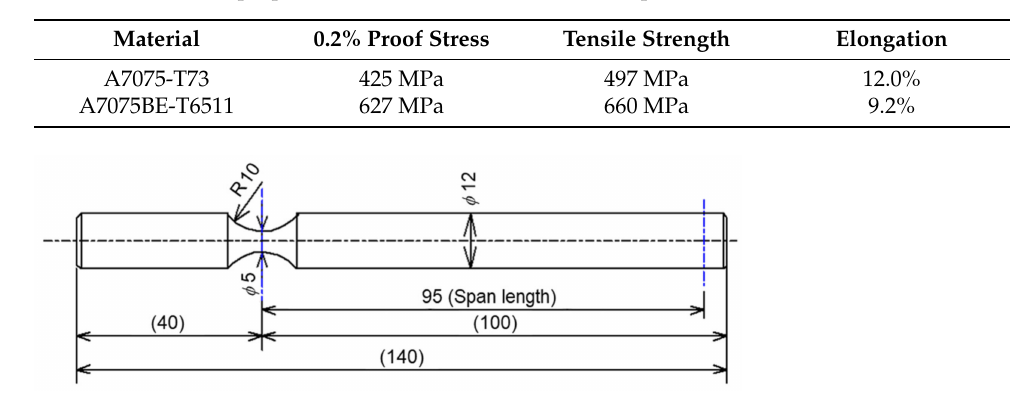
Table 2. Mechanical properties of the materials used in the experiments.